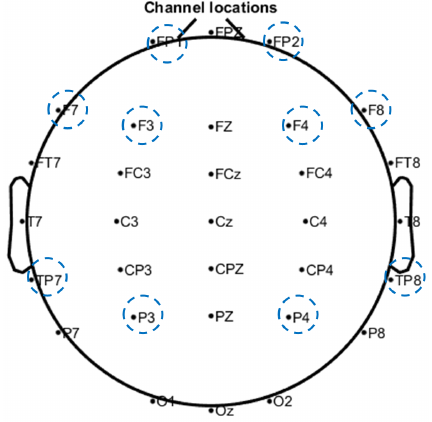
Figure 7. Experimental setup with MITSAR-EEG and HTC Vive headset and controllers.